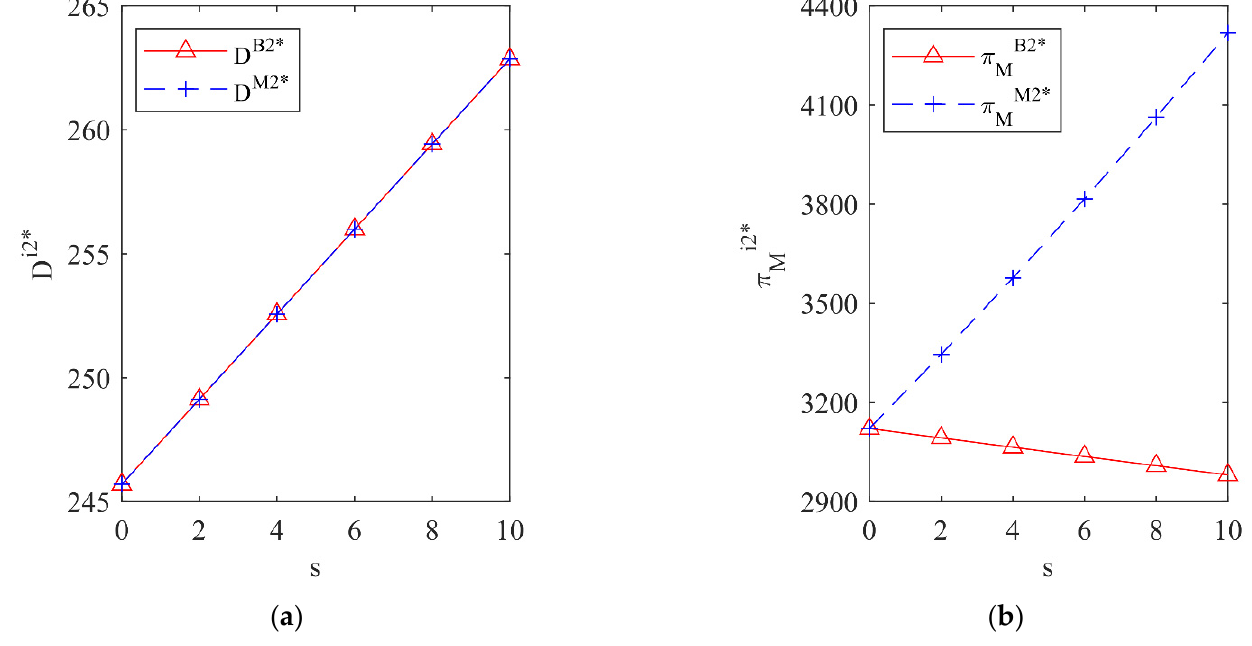
π under investing in R&D. under investing in R&D. M M